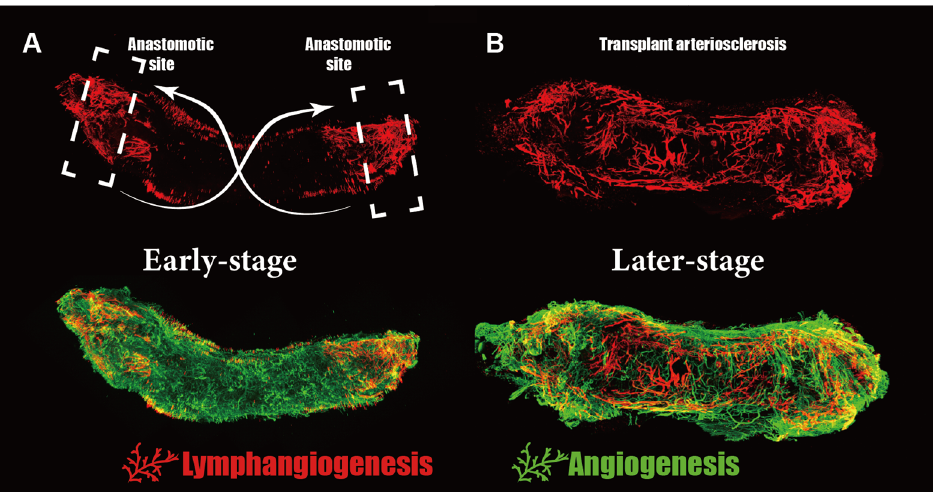
Figure 4. Detection of lymphangiogenesis by whole-mount staining LYVE1 (red) and CD31 (green) at different time points (2/4 week) after vascular transplantation. ( A ) The lymphangiogenesis visibly occurred at anastomotic sites and gradually spread towards the central part. ( B ) Until the fourth week post-transplantation, lymphatic vessels had already spread throughout the allograft vessels. Interestingly, in both time points, parts close to the anastomotic sites possessed the highest density and largest lumen area of lymphatics.